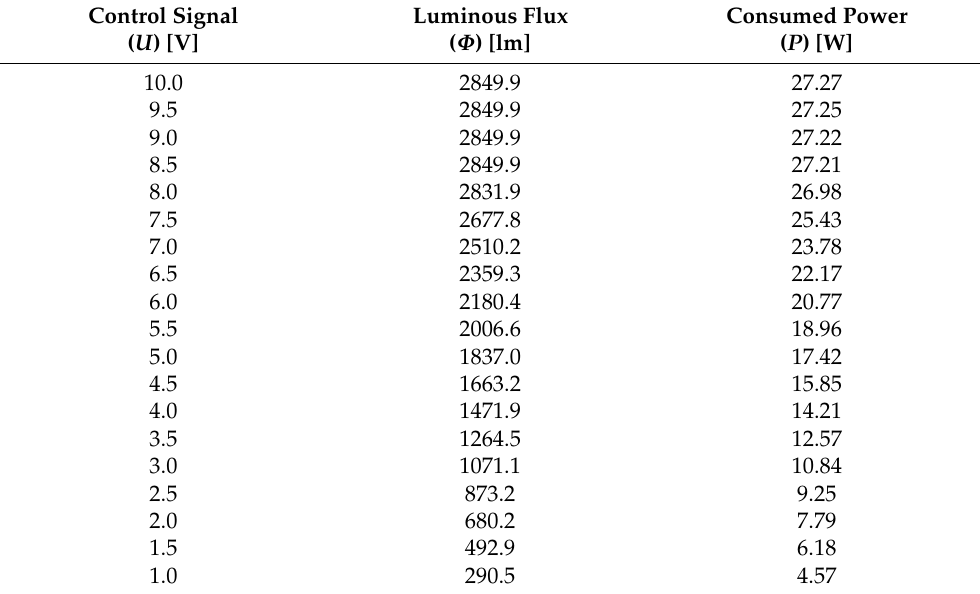
Table 7. Dependence of the luminous flux and the power consumed on the voltage signal controlling the LED_26W